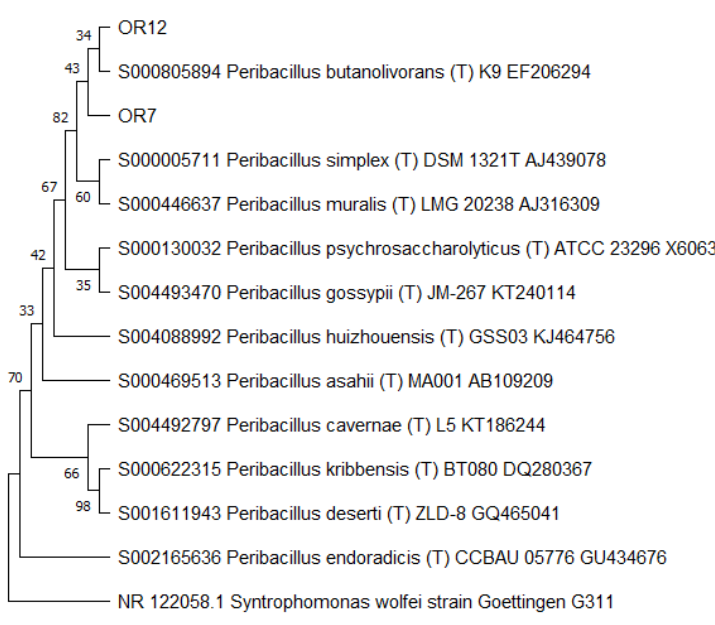
Figure 8. Phylogenetic tree for the genus Peribacillus.